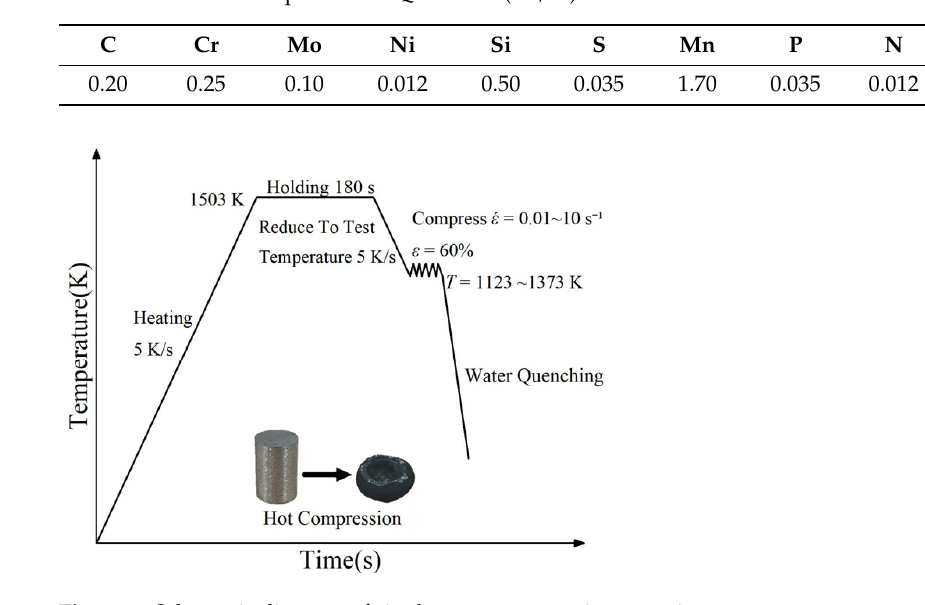
Figure 1. Schematic diagram of single-pass compression experiment.